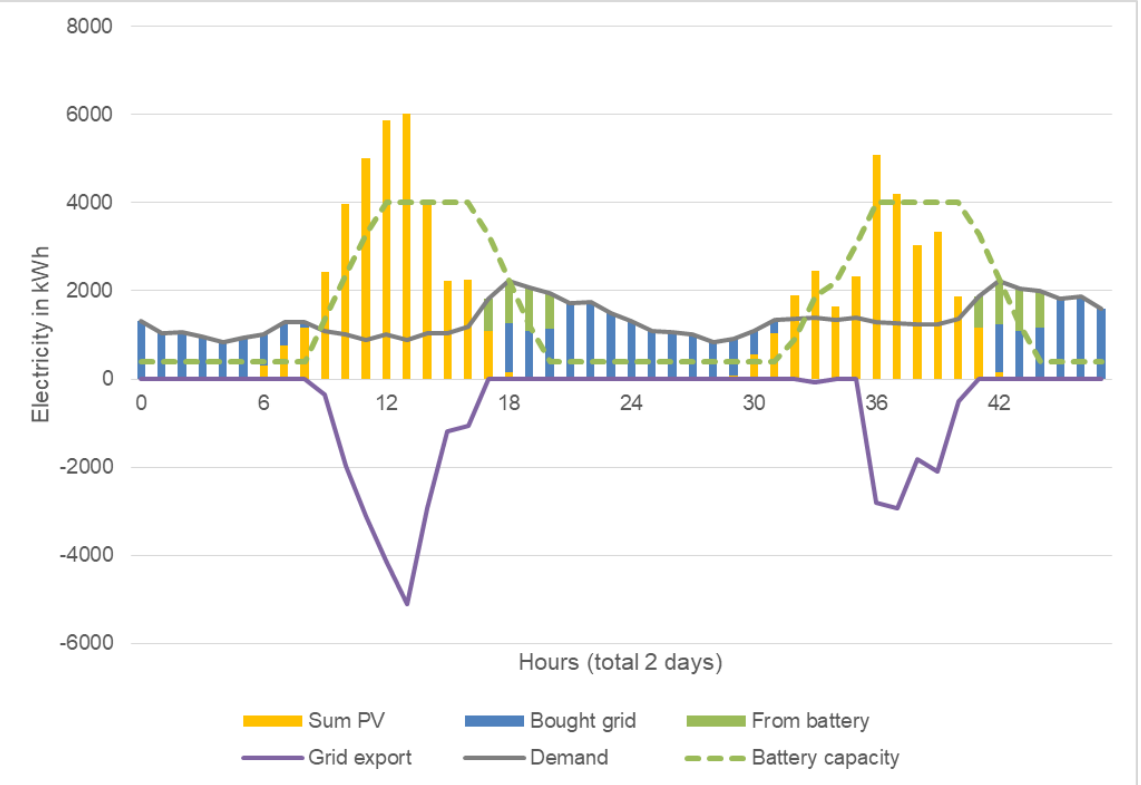
Figure 13. Battery dynamics of the all-electric scenario during two days in April 2010. The graph shows how the energy demand (demand) is fulfilled with PV (sum PV), electricity from the grid (bought grid) and from battery (from battery). The surplus energy is first stored in the battery (battery capacity), and when the battery is full (4 MWh), energy is exported to the grid (grid export).